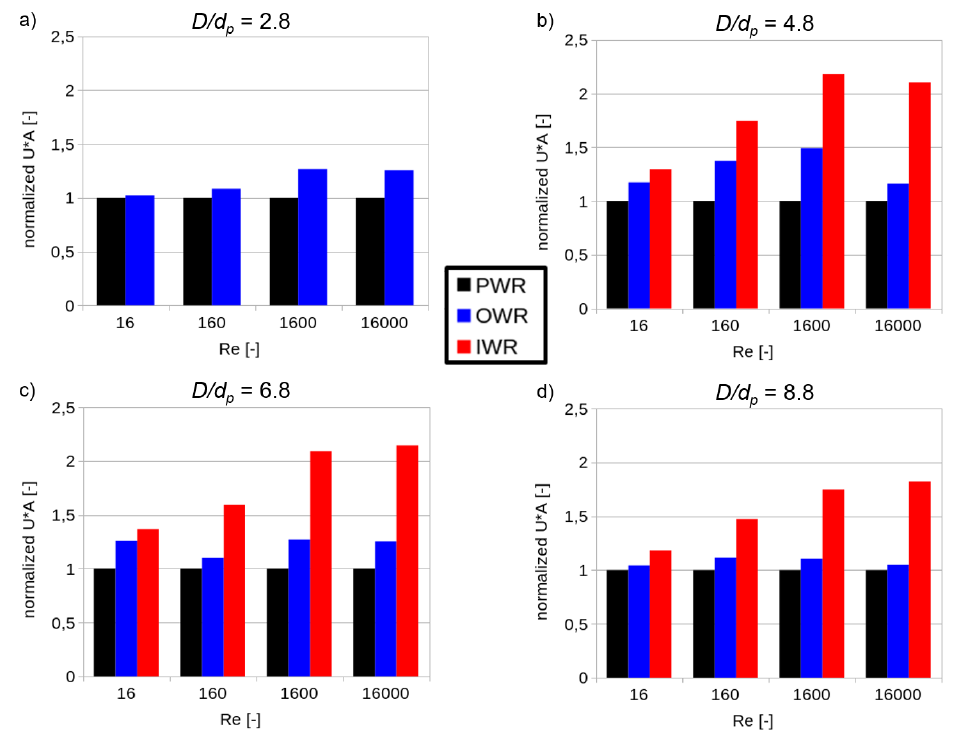
Figure 16. Comparison of normalized U*A as a measure for the thermal performance for varying D / d p -ratios, Reynolds numbers and wall